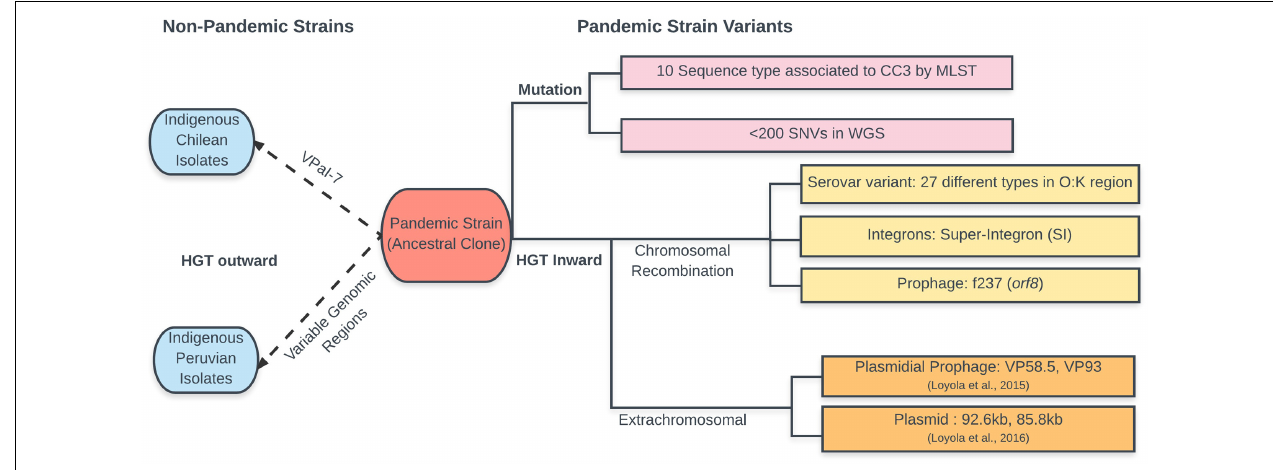
FIGURE 2 | Schematic representation of the changes observed during evolution of the pandemic V. parahaemolyticus clone. According to the text and data in cited references. Changes in the ancestral clone are shown to the left separating mutations from HGT. Transmission of pandemic strain genes to other indigenous V. parahaemolyticus (in blue) is shown to the right of the ancestral